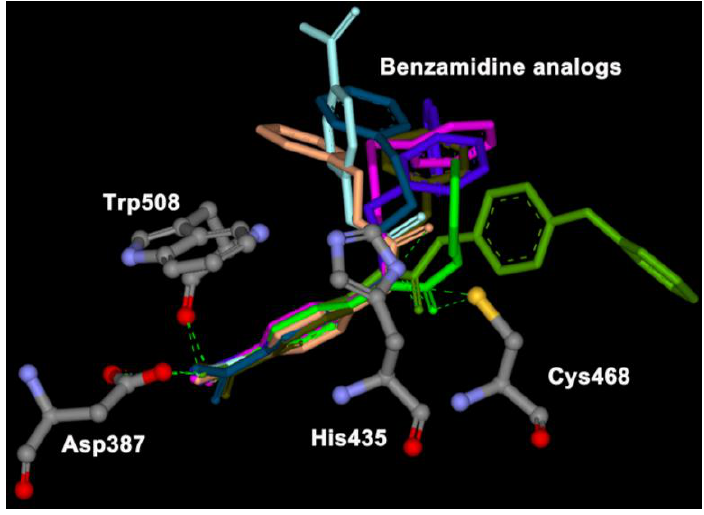
Figure 2. Representative binding poses of eight benzamidine analogs in core binding sites given by the docking calculation.